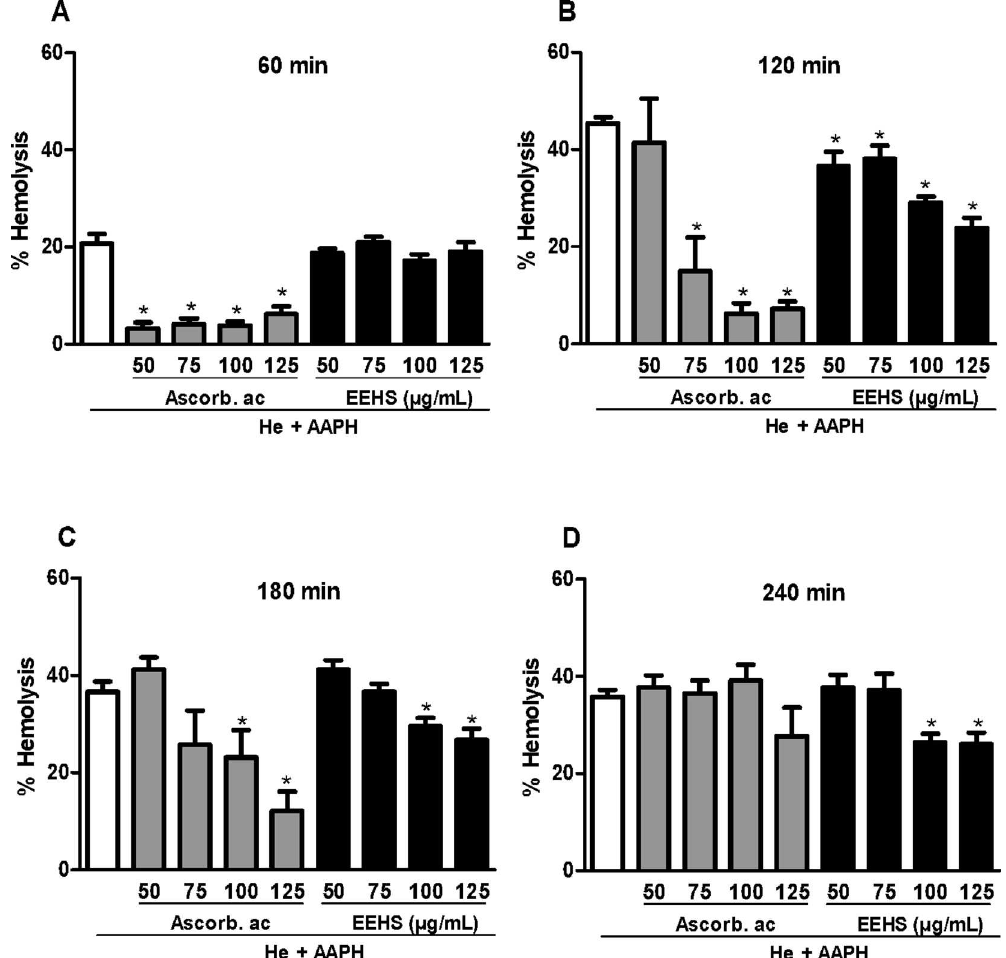
Fig 2. Effects of EEHS on the inhibition of hemolysis of human erythrocytes induced by AAPH. The groups were evaluatedat (A) 60, (B) 120, (C) 180, and (D) 240 min of incubation. The controls consisted of an erythrocyte suspension(2.5%) incubatedwith AAPH alone. Valuesare expressedas the mean ± SEM of three independent experiments performed in duplicate. * P < 0.05 when the treated groupswere comparedwith the AAPH group (erythrocytes incubatedwith AAPH alone)duringthe respectiveincubation